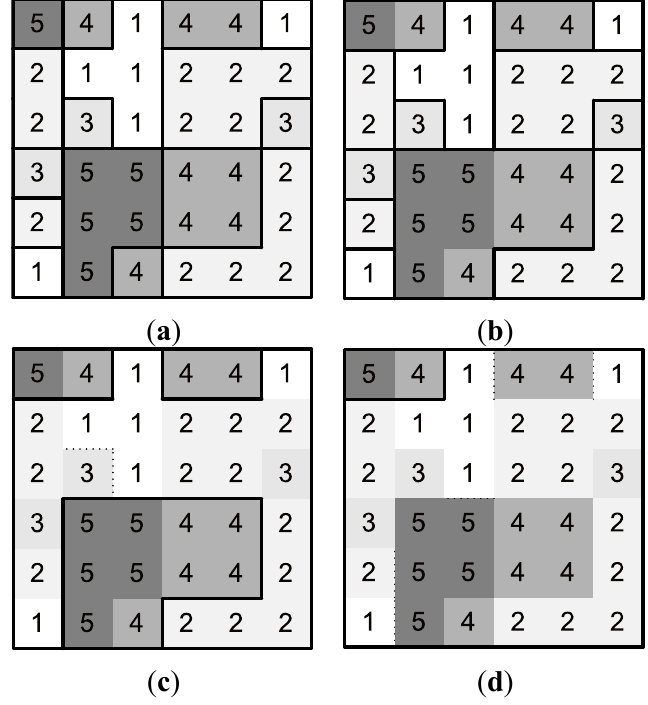
Figure 1. An abstract image, segmented with the (cid:2009) w -CC method illustrating its general characteristics, with (0,0)-CC shown in ( a ), (1,1)-CC in ( b ), (1,2)-CC in ( c ) , and (2,3)-CC in ( d ).